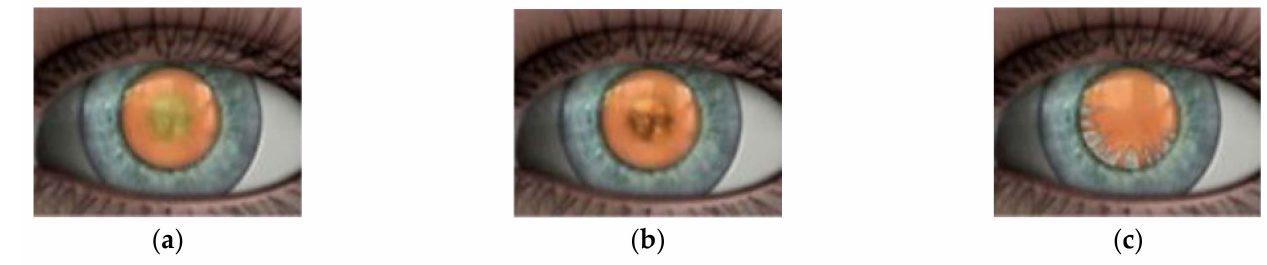
Figure 1. ( a ) Nuclear Cataract, ( b ) Cortical Cataract, ( c ) Posterior Capsular Cataract